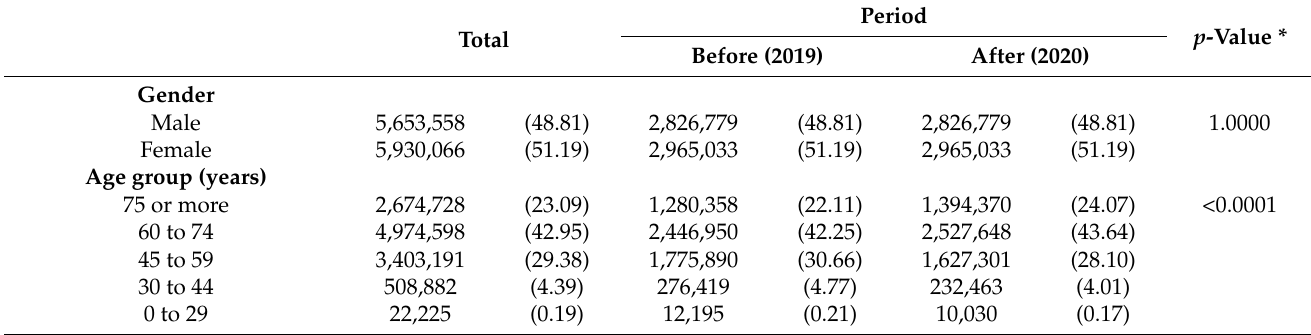
Table 1. General characteristics of the population (cases (%); mean ± standard